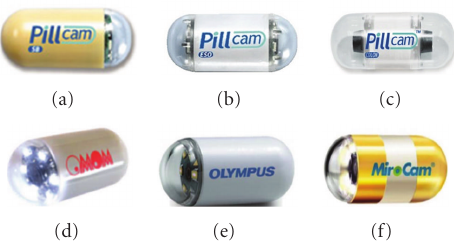
Figure 4: Present clinical capsules: (a) PillCam SB; (b) PillCam Eso; (c) PillCam Colon; [31] (d) OMOM [26]; (e) Olympus [44]; (f) MiroCam